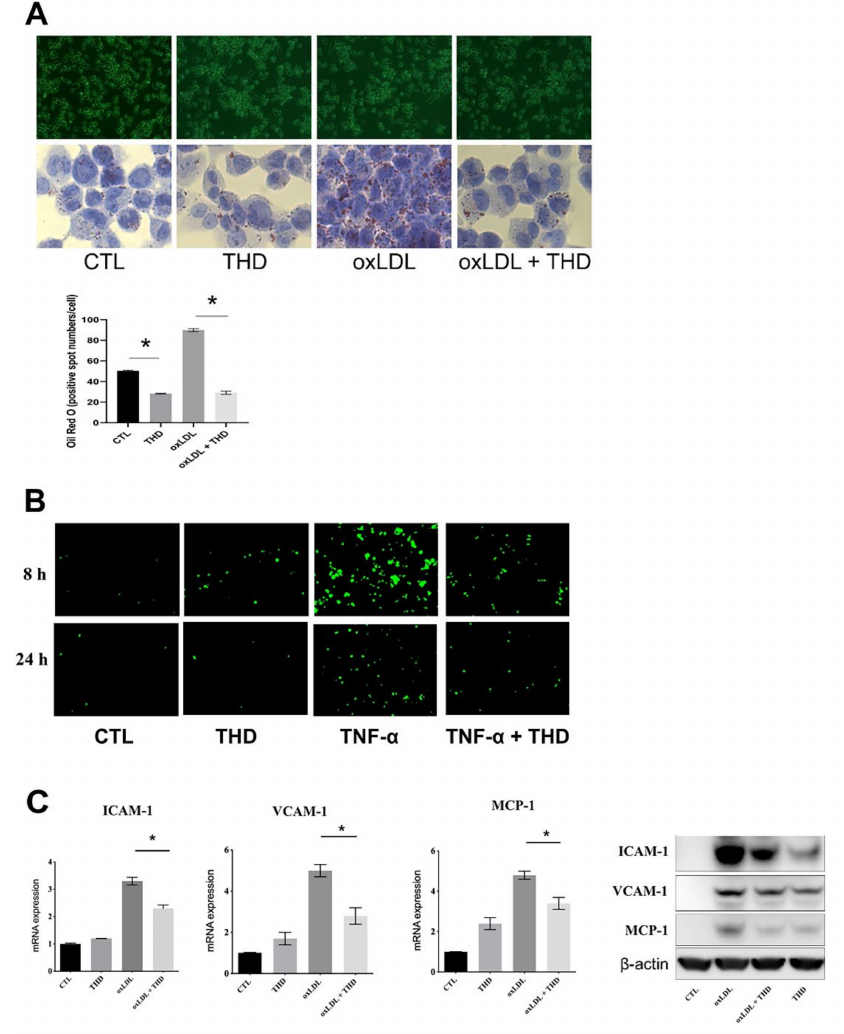
Figure 4. THD inhibits endothelial cell activation. ( A ) THP-1 cells were differentiated into macrophages and incubated with oxLDL (100 µ g / mL) for 24 h, followed by Oil red O staining ( n = 3). ( B ) oxLDL-stimulated HUVECswereincubatedwithfluorescentlylabeledTHP-1cells, followedbyremovalofunboundTHP-1cells ( n = 3). ( C ) HUVECs were activated by oxLDL (100 µ g / mL) treatment, and ICAM-1, VCAM-1, and MCP-1 expression levels were determined by qRT-PCR (left panel) and western blot (right panel) ( n = 3). THD, Tongqiaohuoxue decoction; oxLDL, oxidized low-density lipoprotein; CTL, control; ICAM-1, intercellular adhesion molecule-1; VCAM-1, vascular cell adhesion molecule-1; MCP-1, monocyte chemoattractant protein-1. * p < 0.01 vs. corresponding control. p value was obtained from one-way ANOVA with Tukey’s post- hoc